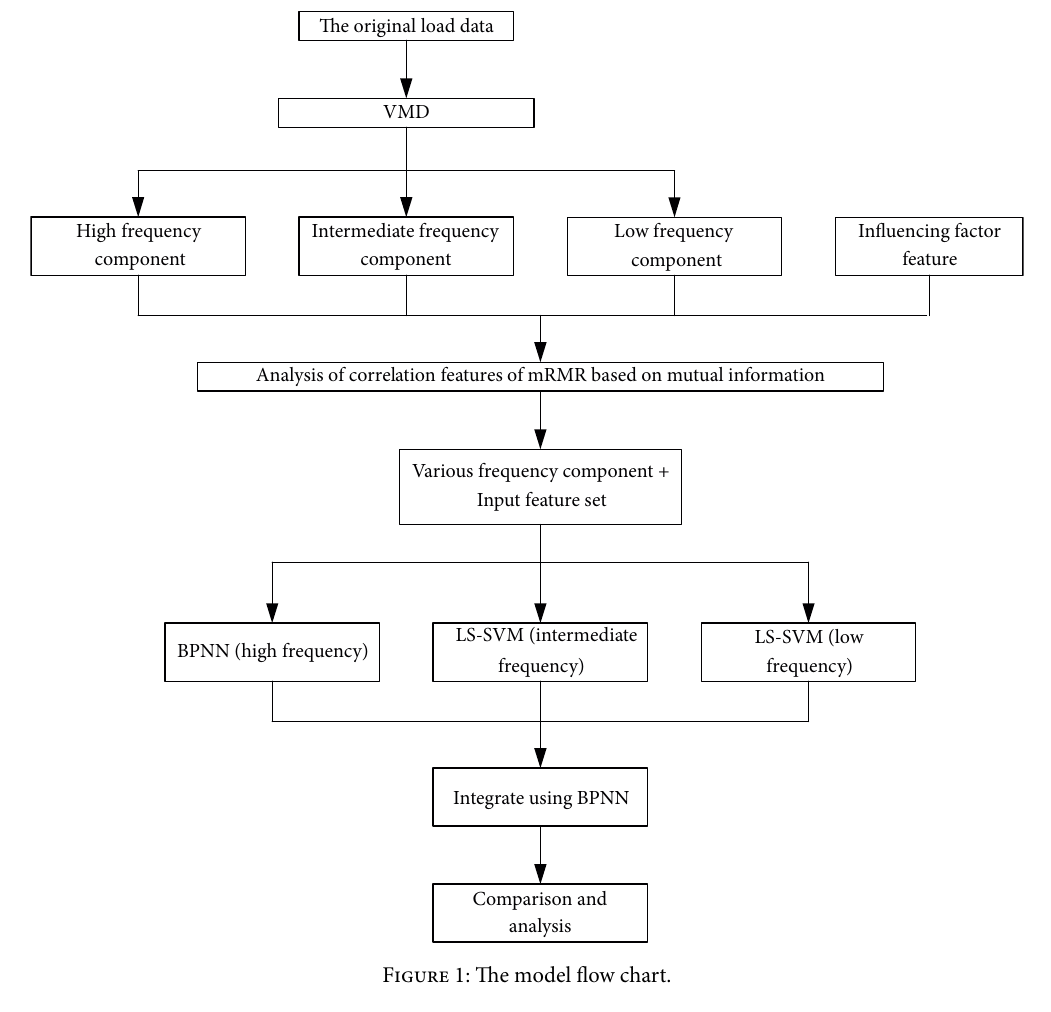
Figure 1: The model flow chart.